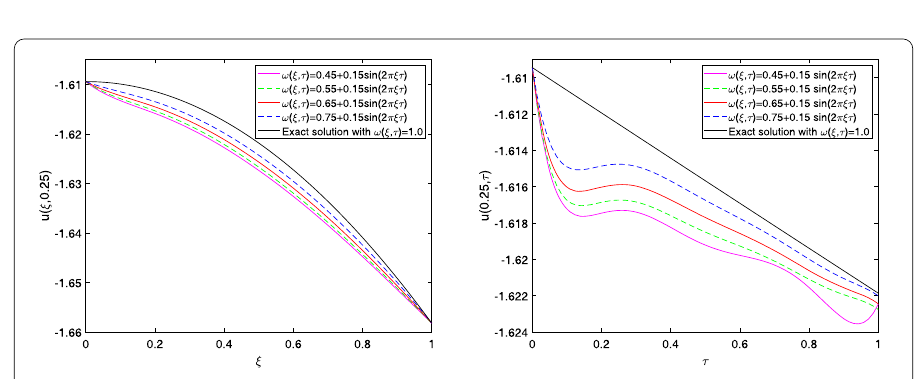
Figure 2 Behavior of the numerical solutions u ( ζ ,0.25) (left) and u (0.25, τ ) (right) for some functions ω ( ζ , τ ) in Example